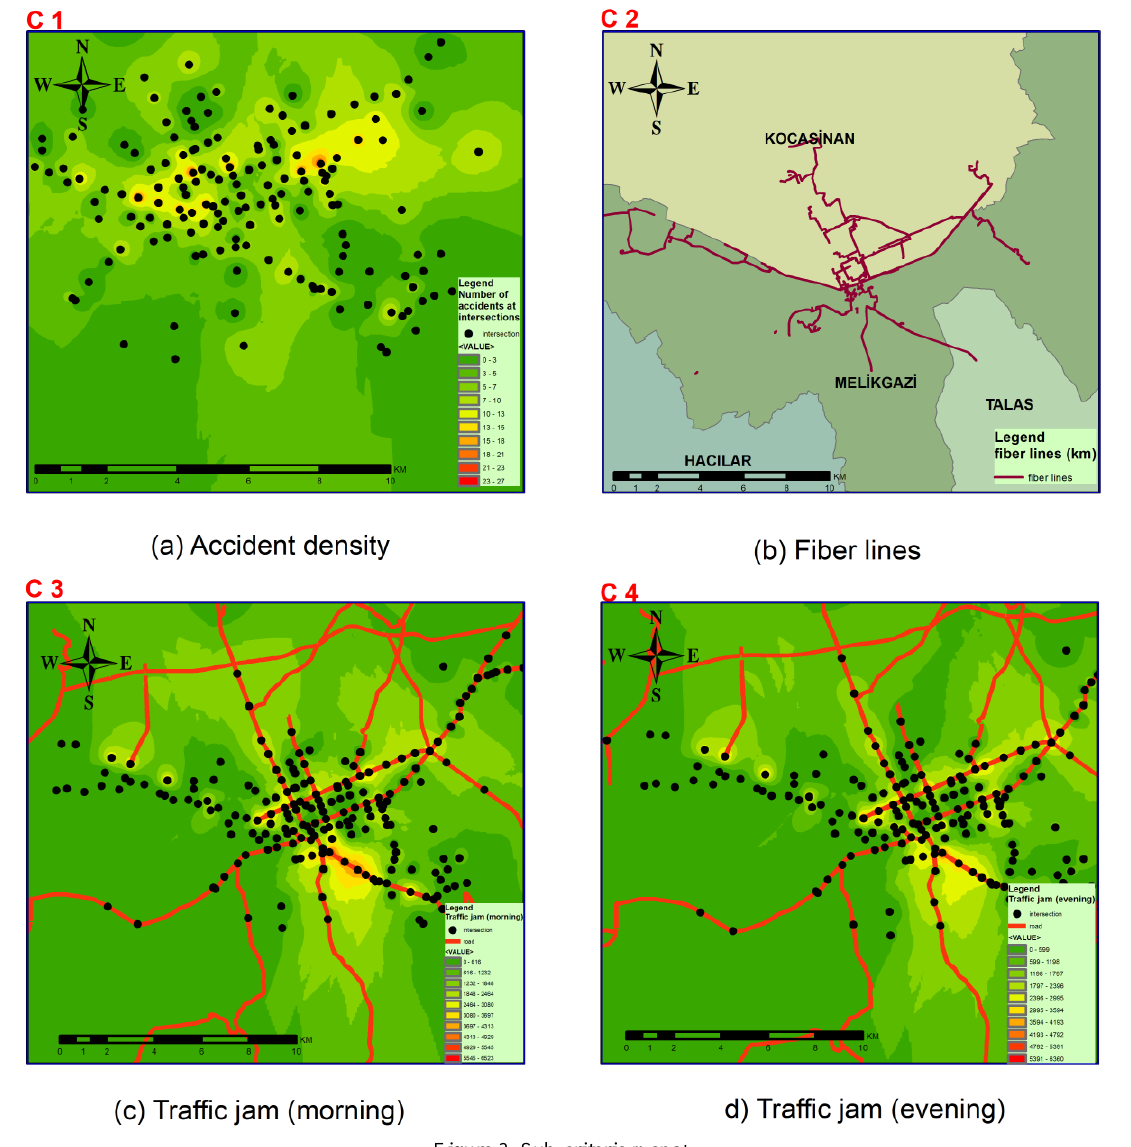
Figure 3. Sub-criteria